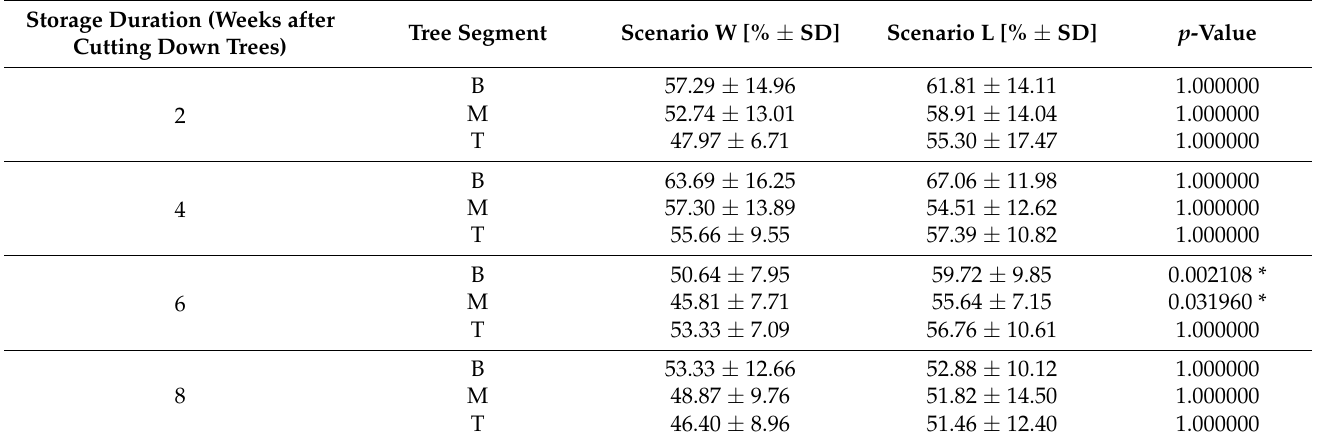
Table 7. Mean and standard deviation of heartwood moisture content (hMC) according to part of the experiment, storage methods and tree